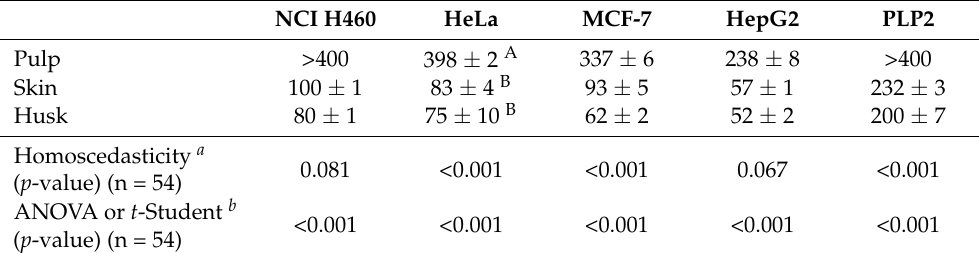
Table 5. Cytotoxicity of pulp, skin, and husk of A. hippocastanum fruits (values are presented as GI 50 values in µ g/mL of extract)). NCI